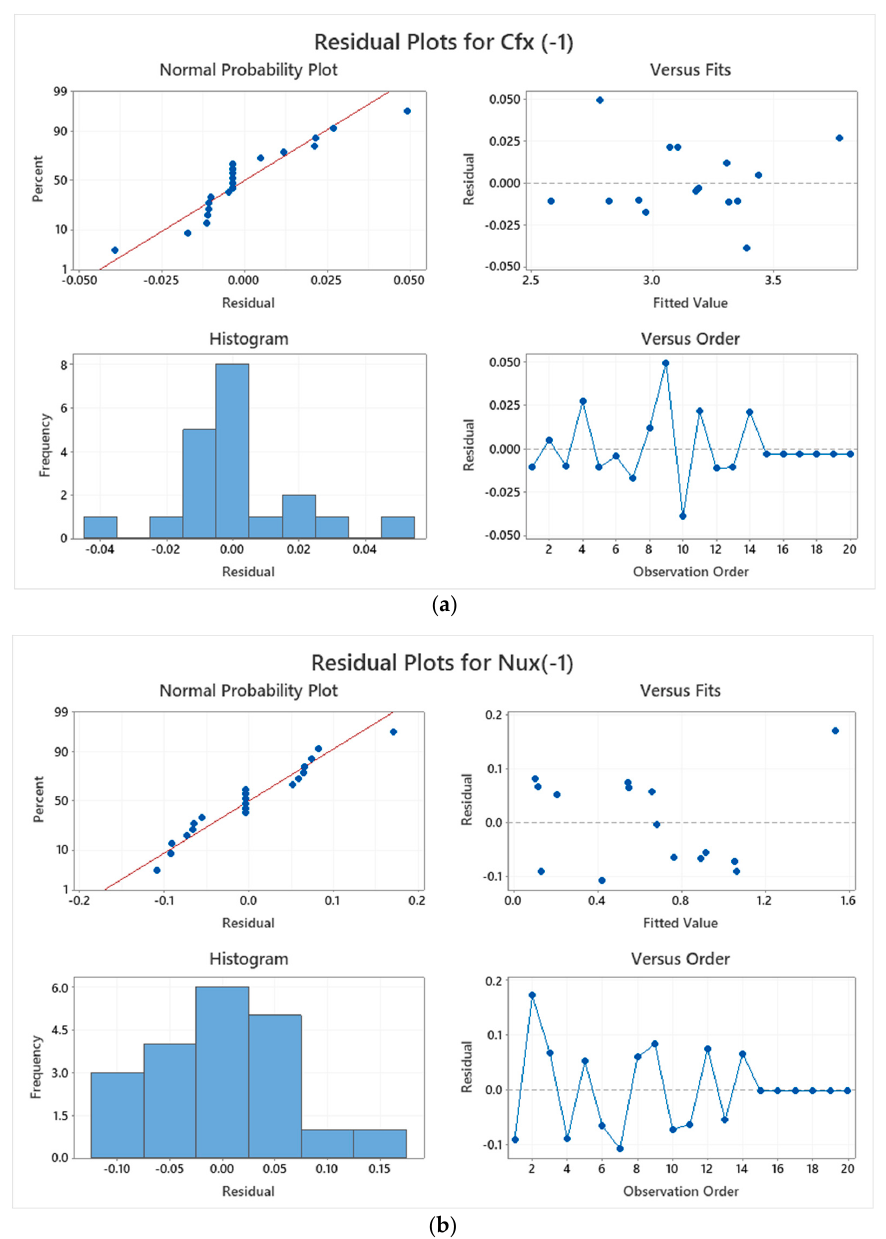
Figure 13. Residual plot for ( a ) 𝐶𝑓 (cid:3051) ( b ) 𝑁𝑢 (cid:3051) .